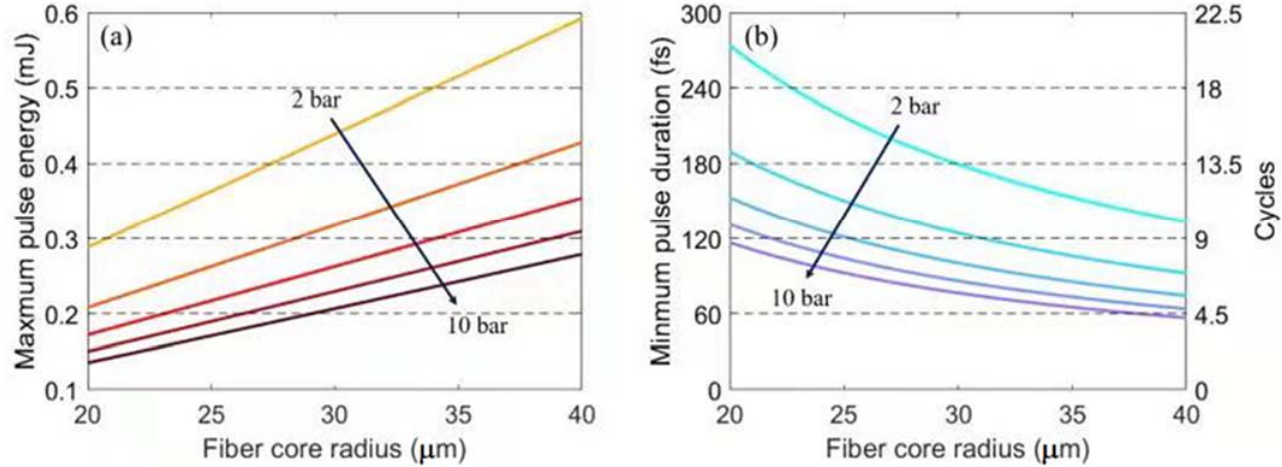
Figure 1. Dependence of E max ( a ) and T min ( b ) on the HCF core radius with the helium pressure at 2 bar, 4 bar, 6 bar, 8 bar, and 10 bar. The pulse is centered at 2 μ m.